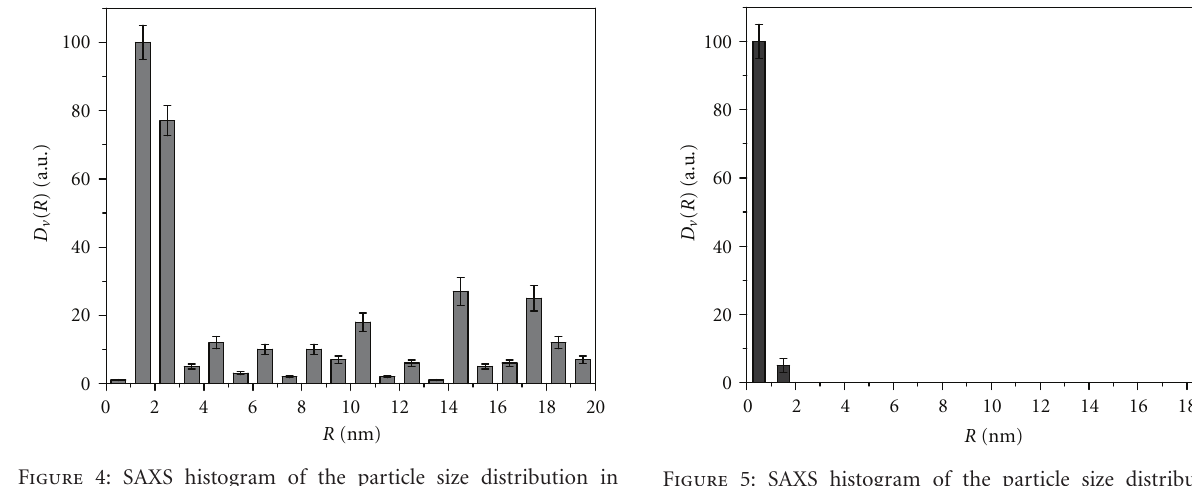
Figure 5: SAXS histogram of the particle size distribution in brookite sample obtained by hydrolysis of TiCl 4 in cold water.